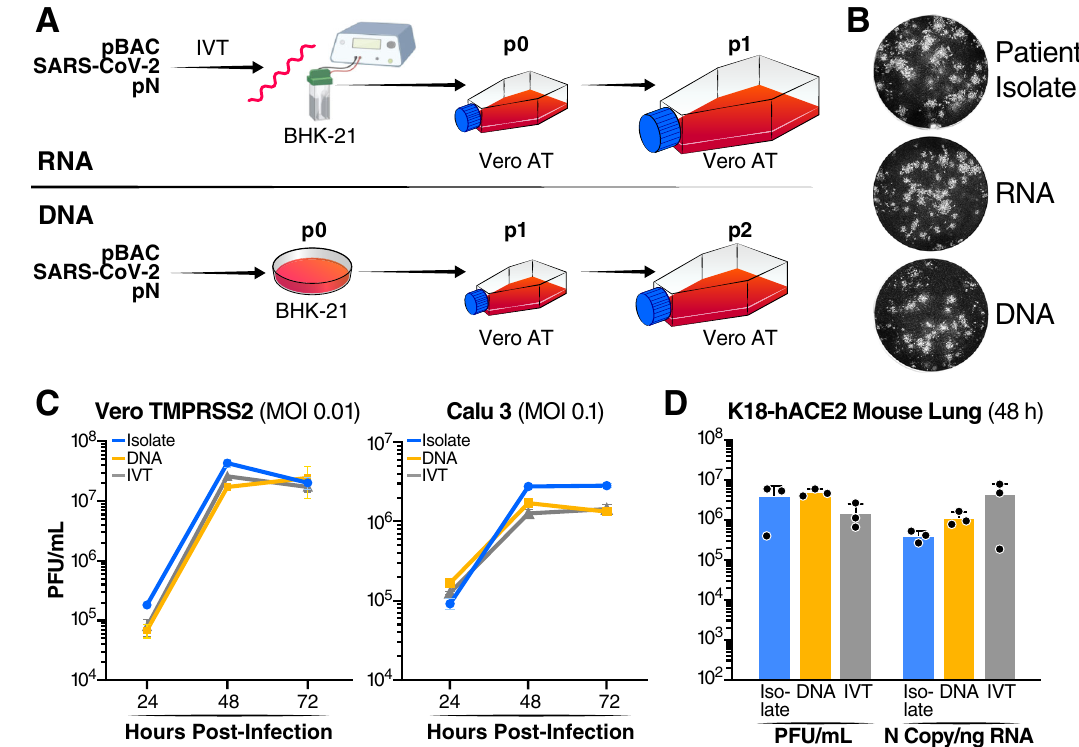
Fig.2|DNA-andRNA-launchedvirusesreplicatesimilarlytovirusderivedfrom patient isolate. A Schematic of virus rescue from RNA or DNA. For RNA-launched virus rescue, in vitrotranscribed RNA from viralconstruct(pBACSARS-CoV-2)and N expression construct (pN) is electroporated into BHK-21 cells followed by co- culture with Vero ACE2 TMPRSS2 (Vero AT) cells to yield p0 viral stock, which is propagated in the same cells onward. For DNA-launched virus rescue, pBAC SARS- CoV-2andpNaredirectlytransfectedintoBHK-21cellstoyieldp0viralstock,which is then propagated in Vero AT cells. B Plaque morphology of DNA- and RNA- launchedand patient-derivedDelta variant viruses. Images were pseudocolored